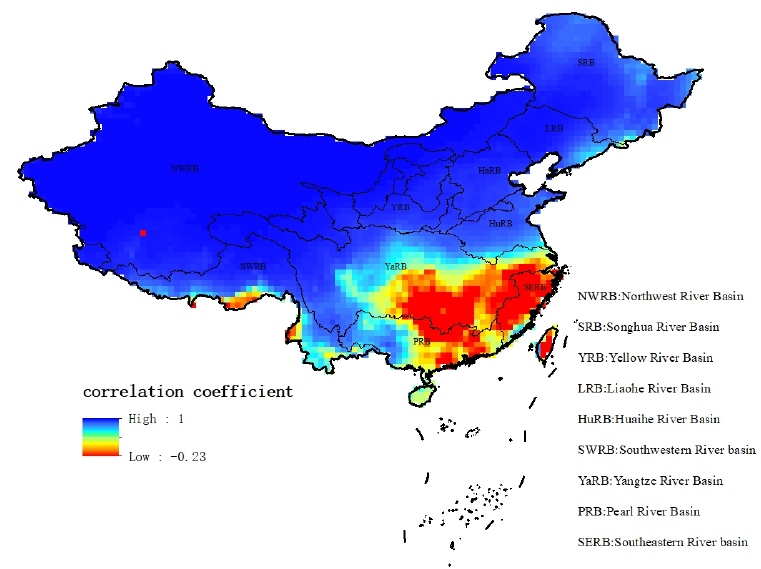
Figure 10. Pearson’s correlation coefficient between P and AET.